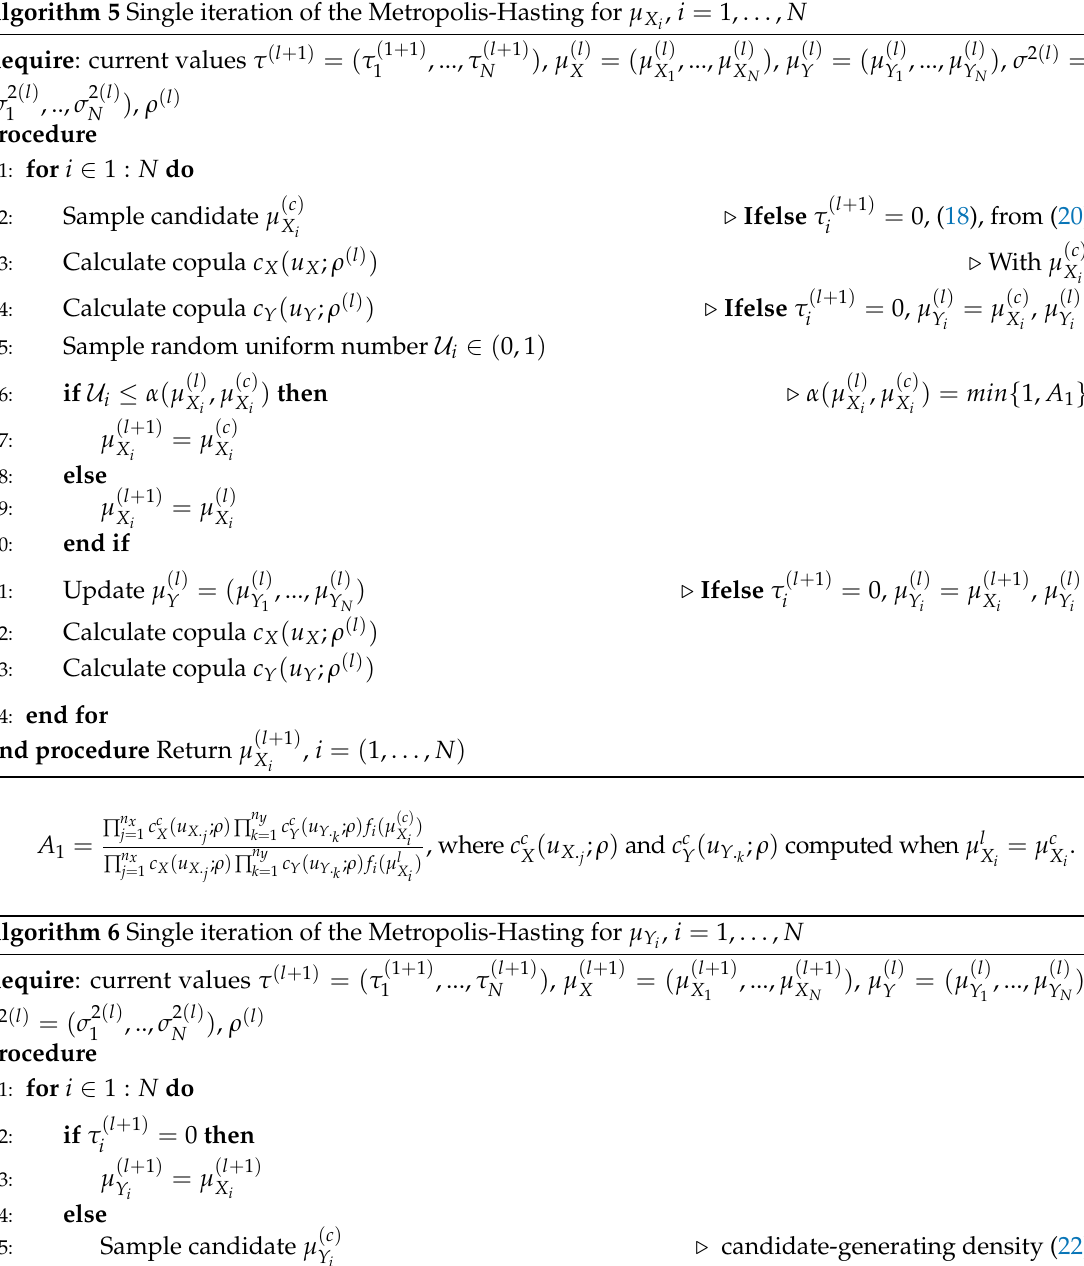
Algorithm 5 Single iteration of the Metropolis-Hasting for µ X